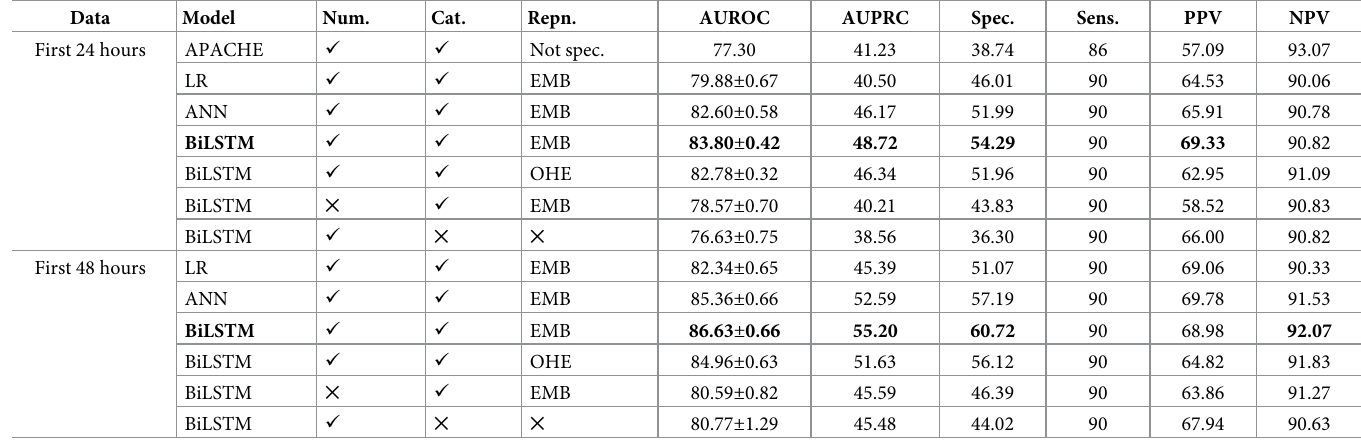
Table 5. In-hospital mortality prediction during first 24 and 48 hours in ICU. ( Num . and Cat . indicate presence of numerical and categorical variables respectively. Repn . indicates representation of categorical variables, either One Hot Encoding (OHE) or embedding (EMB)). Data Model Num. Cat.